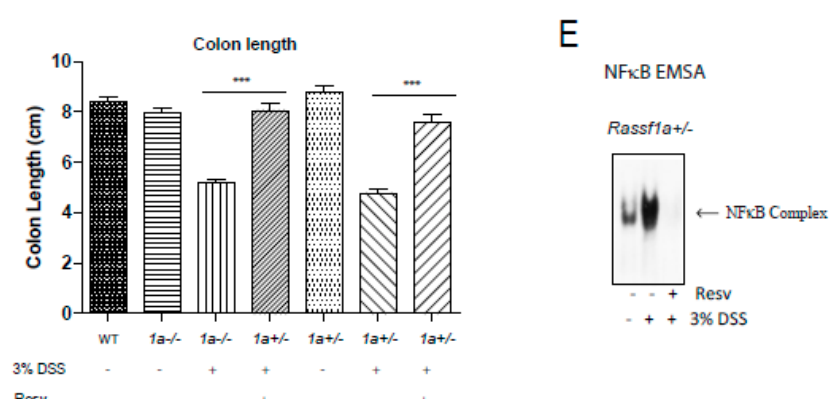
Figure 5. Rassf1a − / − and Rassf1a +/ − knockout mice on resveratrol show decreased susceptibility to disease and enhanced survival. ( A ) Male mice were pre-fed with a resveratrol diet (containing 2 mg resveratrol / g of food) for two weeks prior to DSS. Three percent DSS addition was marked to day 0 and left for 7 days then mice were given regular drinking water for another 7 days. Tissue harvesting was carried out on day 8.5. Shown here is a Kaplan-Meier curve monitoring % survival following DSS treatment. For both the 1a − / − and Rassf1a +/ − knockout mice on resveratrol and DSS, p -value < 0.0001 when compared to counterpart on regular diet and DSS. For Rassf1a +/ − mice injected with Resv-C3 p -value is 0.01 and p -value is 0.005 for Resv-C11 injected mice when compared to counterpart Rassf1a +/ − mice on regular diet and DSS. Resveratrol fed Rassf1a − / − and Rassf1a +/ − knockout mice showed survival rates comparable to wild type when given DSS in drinking water. n > 7. ( B ) Resveratrol fed mice (as in ( A )) or Resv-C3 and Resv-C11 injected Rassf1a − / − and Rassf1a +/ − knockout mice (intraperitoneally at 0.3 mmol / kg body weight every two days) showed less susceptibility to disease when given DSS in drinking water. Disease activity indices (DAI) accounted for several parameters including piloerection, bloated gut, movement, rectal bleeding, hunching, diarrhea, and weight loss. A numerical value of 1 to 5 was given with 5 being severe. If an animal was found dead 5 points added to previous day DAI. N > 7 * p -value < 0.05, ** p -value < 0.01, and*** p -value < 0.001. Ifnotstated, p -value > 0.05.( C )Representative figures of the descending colon (longitudinal cross-section) stained with hematoxylin and eosin (H&E) for knockout mice fed with resveratrol reveal a well-defined crypt structure. ( D ) Colon length was measured at day 8.5 of DSS treatment. Resveratrol maintained “normal” (wild type) lengths indicative of non-injured healthy colon. N > 7 * p -value < 0.05, ** p -value < 0.01, and *** p -value < 0.001. If not stated, p -value > 0.05. (E) NF κ B electrophoretic mobility shift assay (EMSA) on bone marrow-derived macrophage (BMDM) nuclear extracts as described earlier reveals resveratrol inhibition of NF κ B activity in Rassf1a +/ −